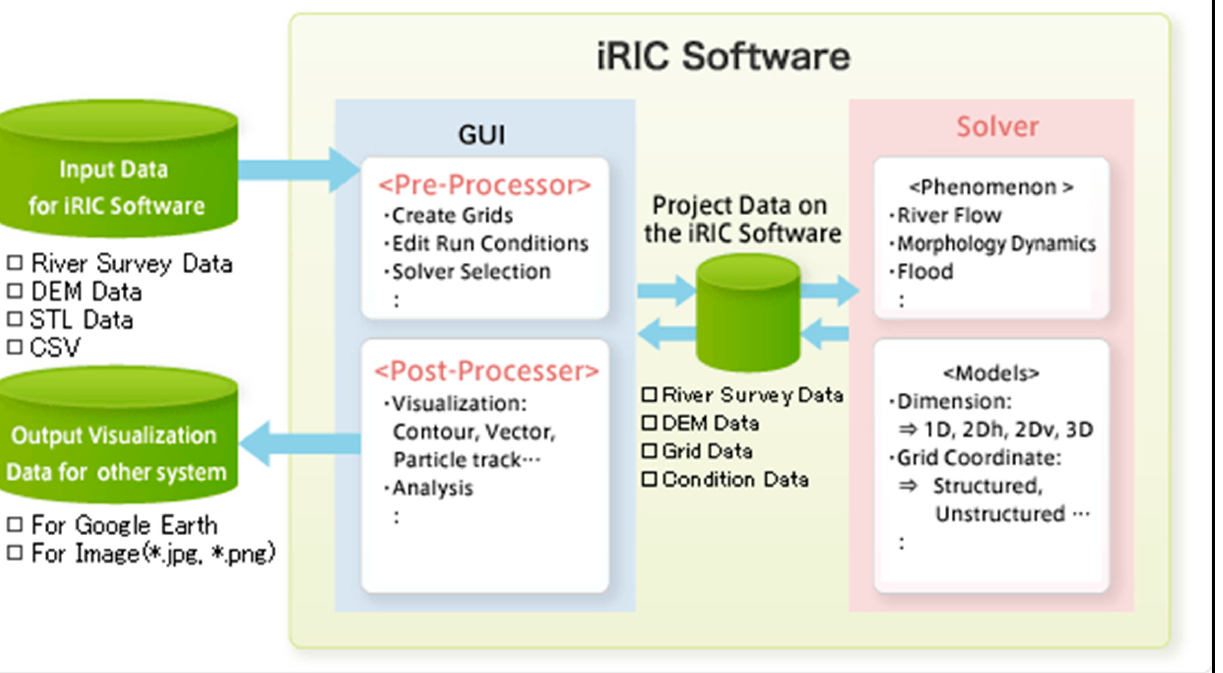
Figure 2. Typical procedure layout of the software (http://i-ric.org/en/introduction accessed on 26 August 2022).